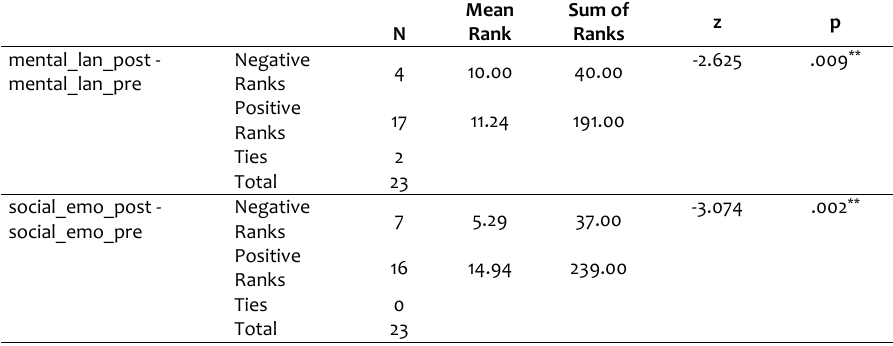
Table 6. Pre-test and post-test results of the development scores in the control